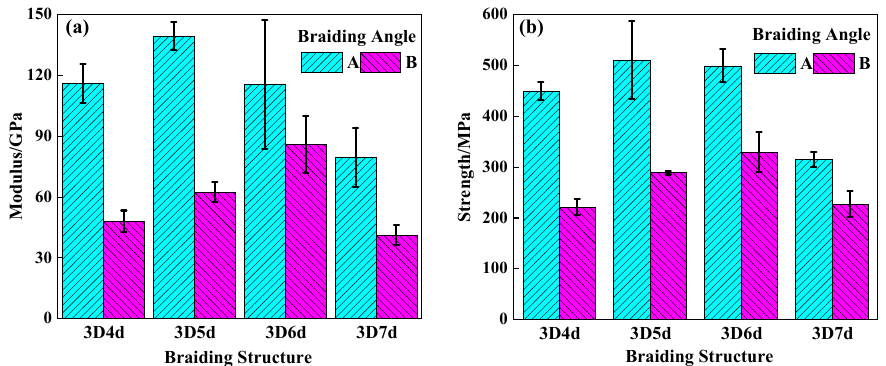
Figure 9. The compressive ( a ) modulus and ( b ) strength of different specimens.